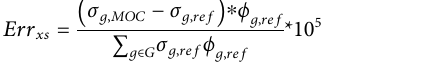
FIGURE 7 Geometry of intermediate spectrum problem (unit: mm).